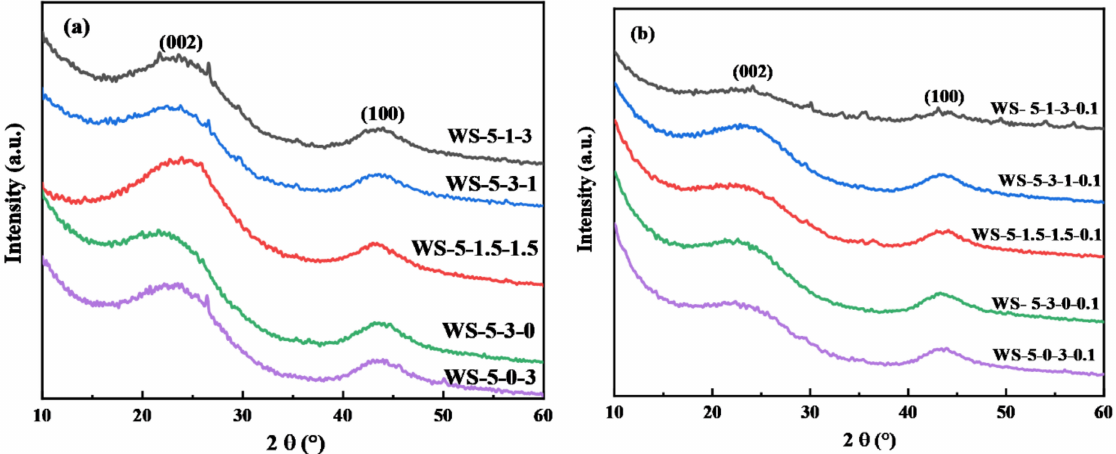
Figure 3. The XRD spectra of biochar prepared by ( a ) different ratios of metal salts and ( b ) different ratios of metal salts and 0.1 mL min − 1 H 2 O(g)